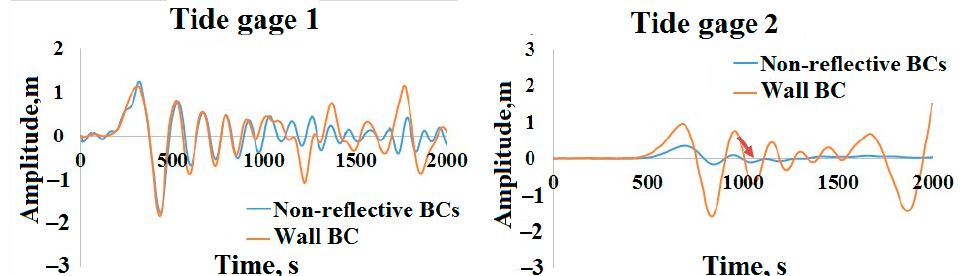
Figure 9. Tide gauge data.